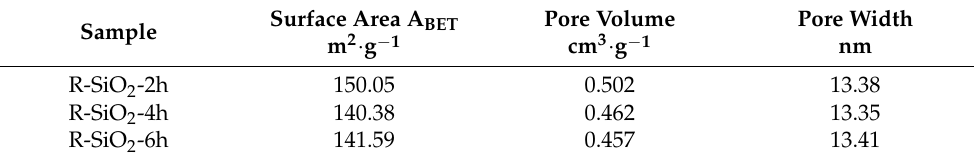
Table 2. Surface area and pore characteristics of biochar–silica composites.